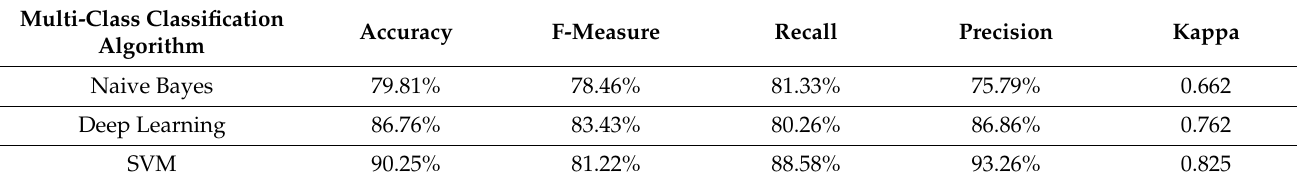
Table 2. Performance of Naive Bayes, SVM, and deep learning multi-class classification. Multi-Class Classification